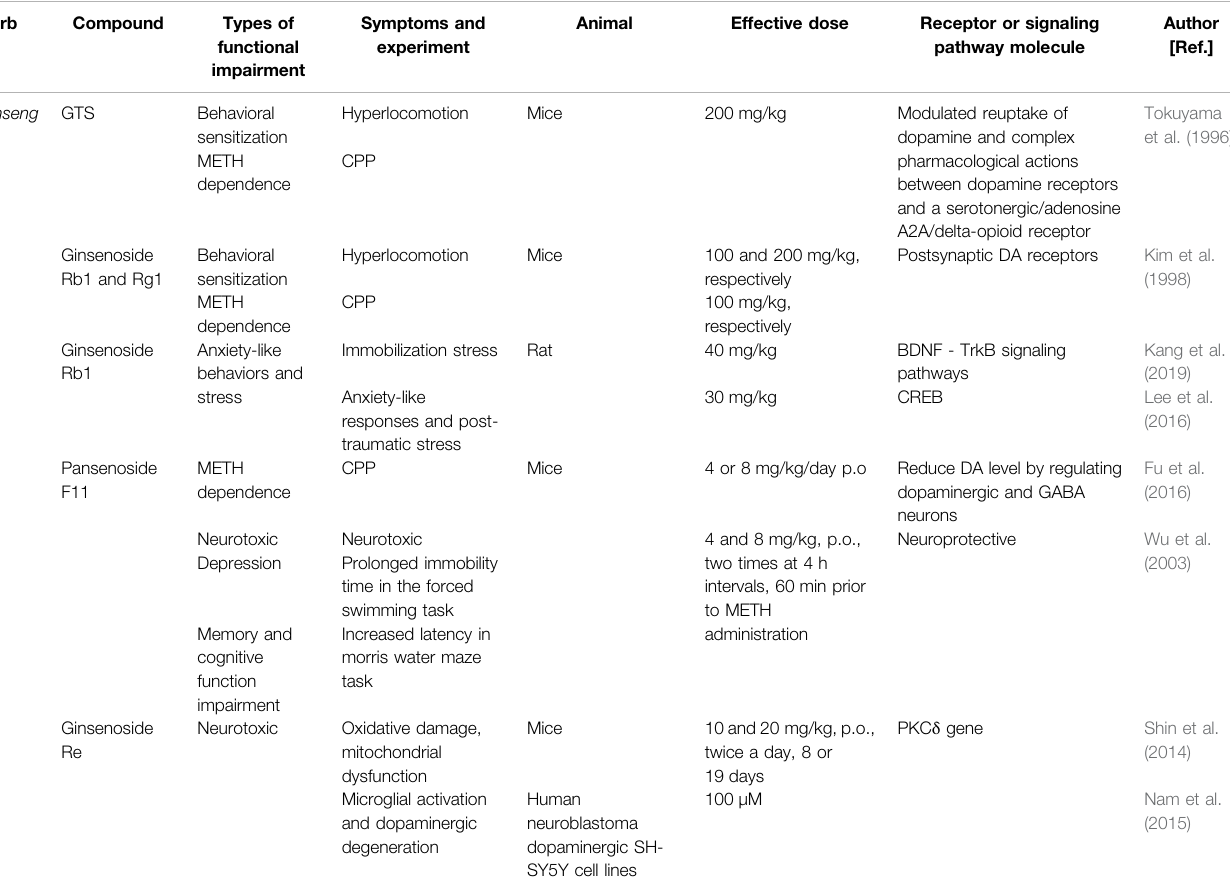
TABLE 3 | Summarized effects of TCM ginseng therapy on METH abuse and other psychiatric symptoms.